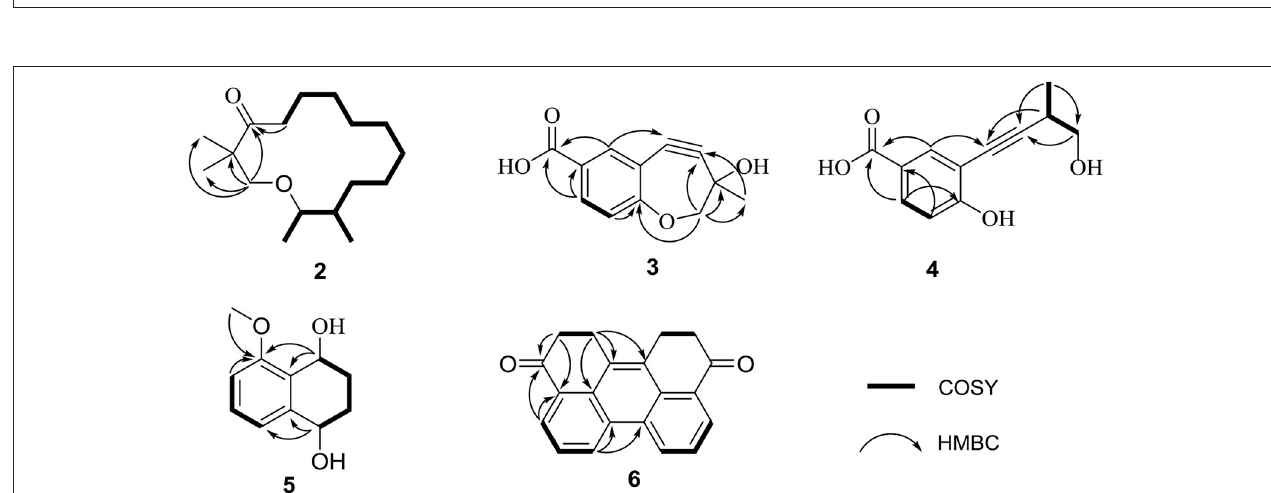
FIGURE 3 | Key HMBC and COSY correlations of 2-6